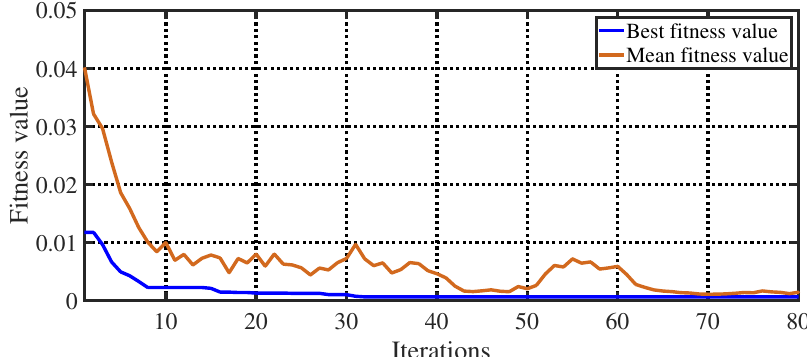
Figure 14. Dynamics in fitness value during the identification